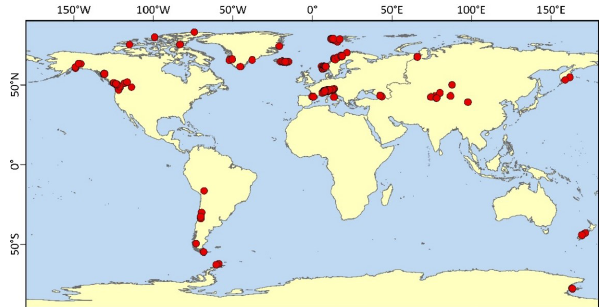
Figure 5. Glacier locations used for comparison of winter and sum- mer balances (from WGMS, 2020). All glaciers had been observed for periods longer than 5 years. The numbers of glaciers in each re- gion are 51 in Alps, 7 in Andes, 3 in Antarctica, 3 in Arctic North America, 3 in Caucasus, 2 in Dry Valley, 5 in Greenland, 13 in high- mountain Asia (HMA: Tien Shan, Altai, Qilian), 12 in Iceland, 2 in Kamchatka, 3 in New Zealand, 38 in Scandinavia, 9 in Svalbard, 2 in the Urals, and 27 in western North